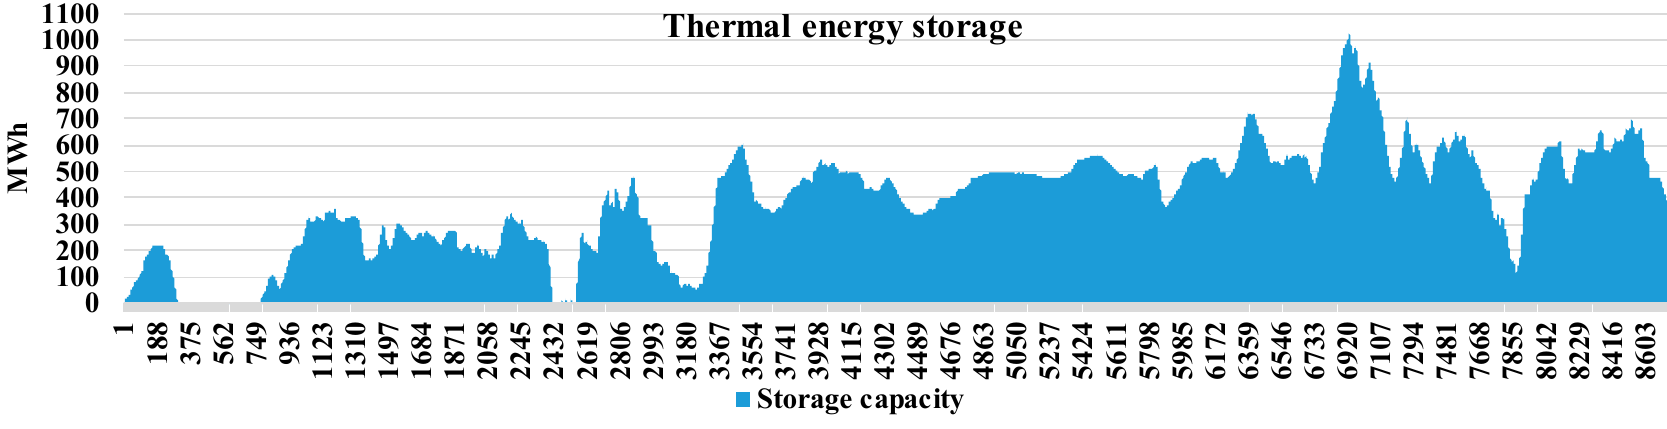
Figure 5. Hourly thermal storage levels (MWh th ) for the year. Maximum storage capacity is 1100 MWh th . Thermal storage has a strong coupling with heat pump use in the district heating system, thereby allowing excess electricity to be stored as heat in long-term storage.